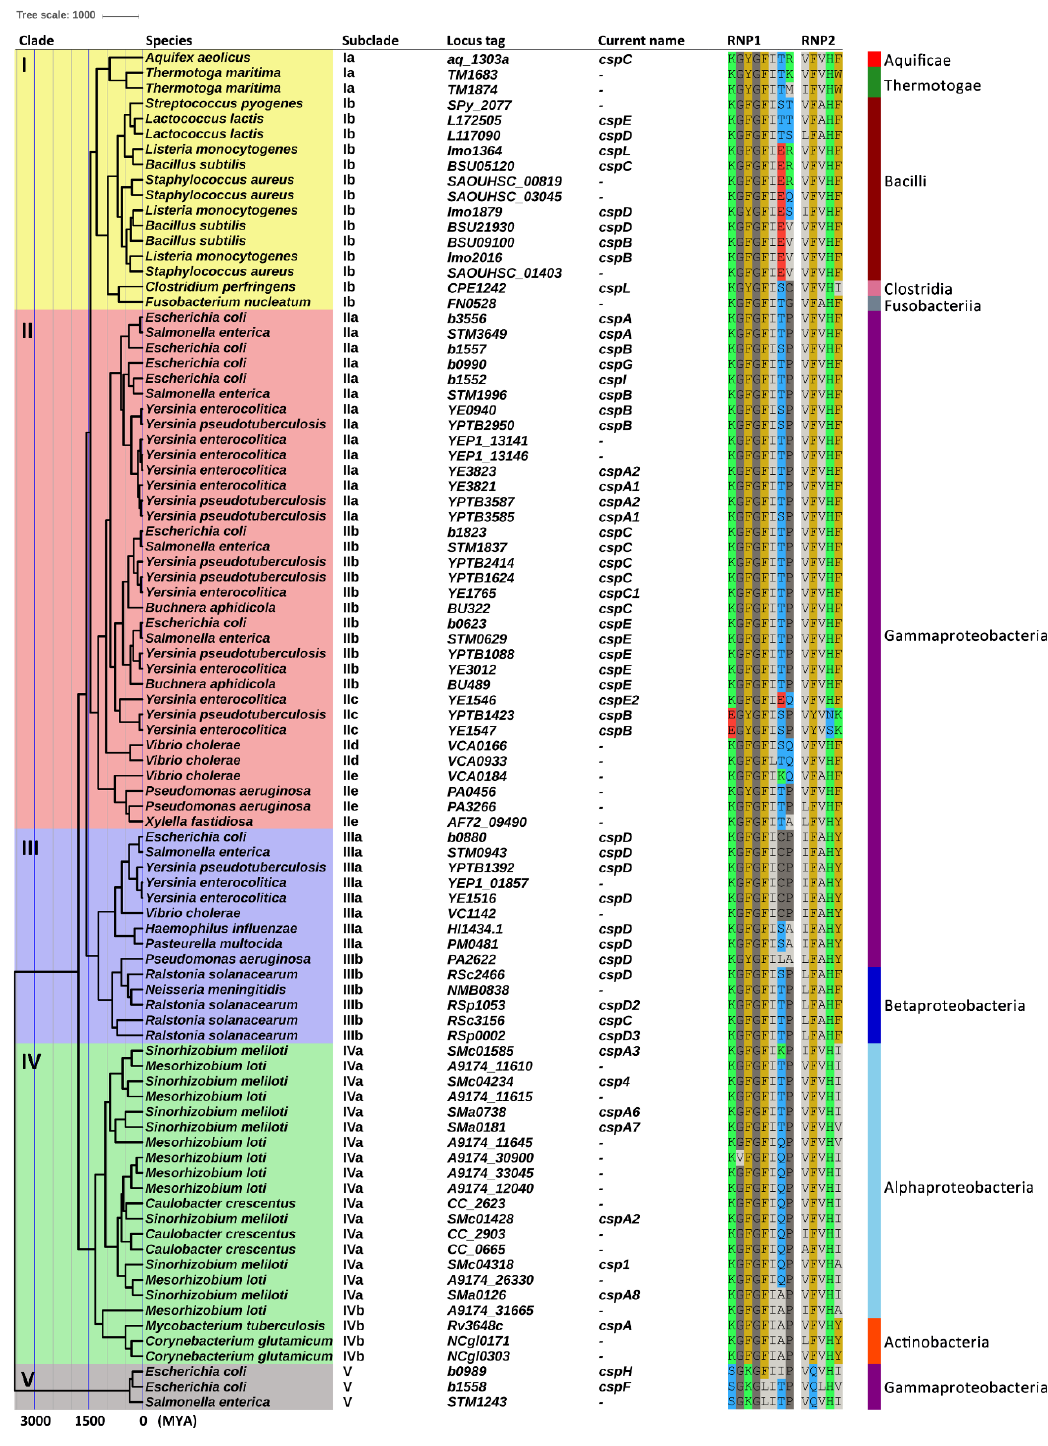
Figure 5. A maximum clade credibility tree of csp genes in eubacteria. Branch lengths are scaled to years. Branch lengths are given as millions of years ago (MYA). The phylogenetic clades of Csps are represented by color. The bacterial class of the organism containing each csp gene sequence is represented by the color of the strip.